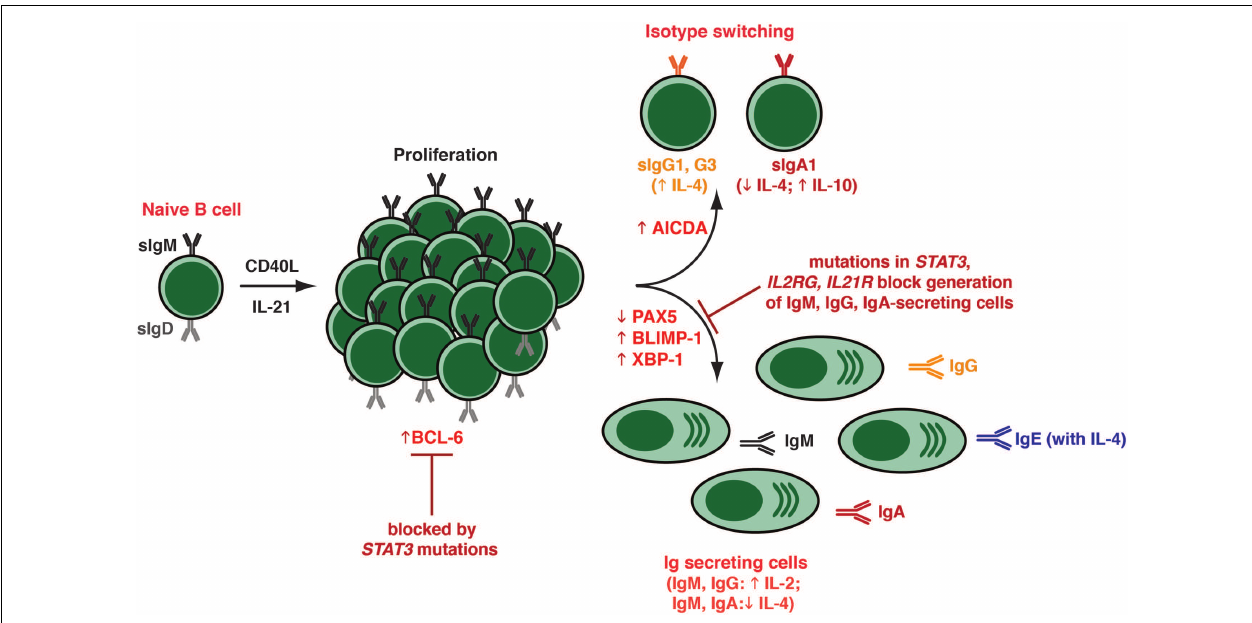
switching and plasma cell formation induced by IL-21 could be modulated by additional cytokines, such as IL-4 (promoted switching to IgG; inhibited switching to IgA; increased secretion of IgG and IgE; suppressed secretion of IgM, IgA), IL-10 (increased IgA secretion), and IL-2 (increased secretion of IgM, IgG).These differentiation events coincided with the induction in expression of BCL-6, AICDA (required for class switching), and BLIMP-1/XBP-1 (required for plasma cell formation).The ability of IL-21 to induce naïve B cells to differentiate into plasmablasts/plasma cells in vitro was abolished by hypomorphic mutations in STAT3 , as well as null mutations in IL21R or IL2RG